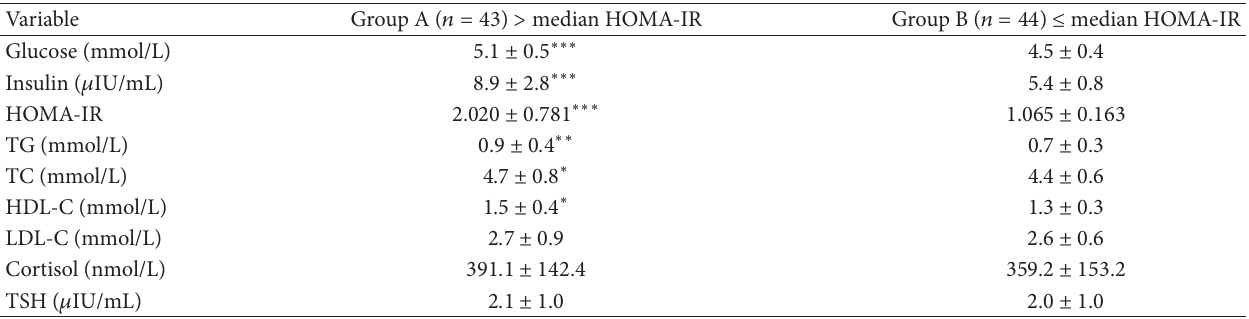
Table 4: Biochemical variables in subjects differed by HOMA-IR (means ± SD).